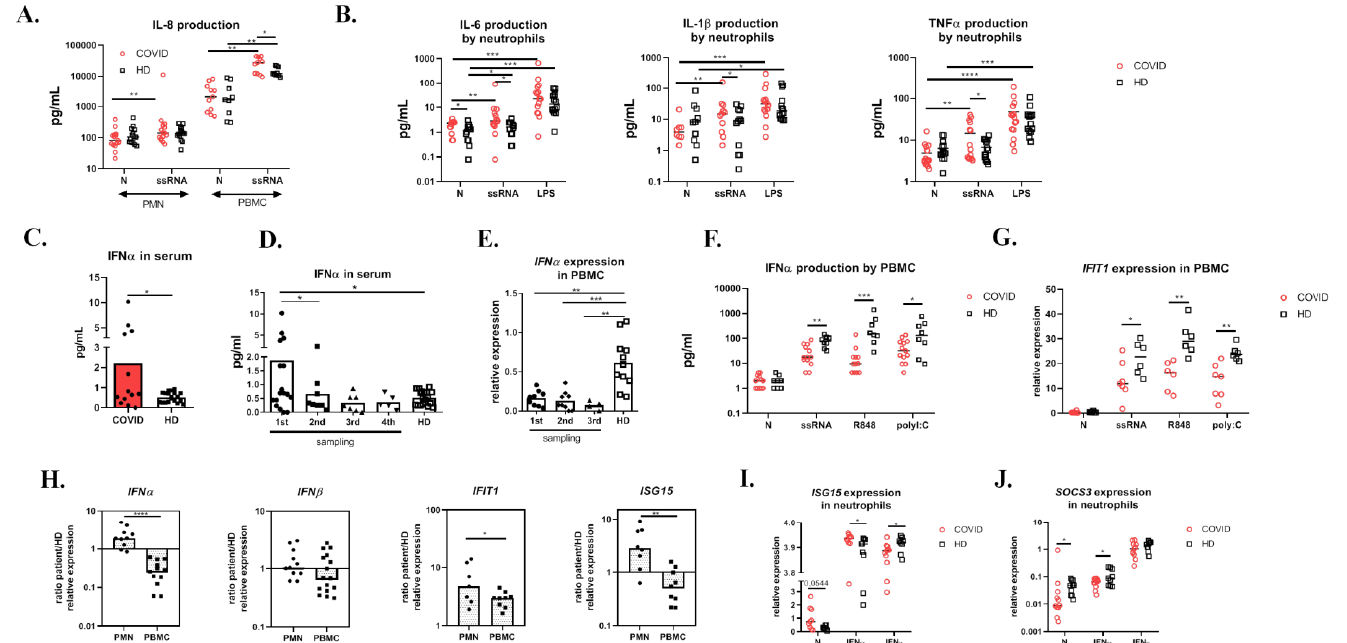
Figure 2. Cytokine production. ( A ) IL-8 concentration in cell-free supernatants of isolated neutrophils and PBMCs from COVID-19 ( n = 15) and HD ( n = 15) upon 10 µ g / mL ssRNA stimulation overnight detected by Luminex. ( B ) Isolated neutrophils from 14 COVID-19 patients and 14 HD were stimulated overnight with 10 µ g / mL ssRNA or left untreated and the production of IL-6, IL-1 β , and TNF α was analyzed with Luminex. ( C ) Serum level of IFN α in 13 COVID-19 and 19 HD analyzed by ELISA. ( D ) Dynamics of serum levels of IFN α during the course of the disease (four di ff erent time points in 1–4 weeks). ( E ) Dynamics of IFN α expression by COVID-19 ( n = 9) and HD ( n = 11) PBMCs during the course of the disease (four di ff erent time points in 1–4 weeks) detected by RT-PCR. ( F ) IFN α production by COVID-19 ( n = 13) and HD ( n = 8) PBMCs upon 10 µ g / mL ssRNA, 1 µ g / mL R848, and 50 µ g / mL polyI:C overnight stimulation detected in cell-free supernatants by Luminex. ( G ) IFIT expression by COVID-19 ( n = 6) and HD ( n = 6) PBMCs upon 10 µ g / mL ssRNA, 1 µ g / mL R848, and 50 µ g / mL polyI:C stimulation for 4 h. Expression was normalized to GAPDH. ( H ) IFN α , IFN β , IFIT , and ISG15 expressions by COVID-19 PBMCs ( n = 9–16) and neutrophils ( n = 7–10). The relative expression was calculated using the following formula (expressed gene / GAPDH of COVID-19 / median of (Expressed gene / GAPDH of all HD samples)). ( I , J ) ISG15 and SOCS3 expression by COVID-19 ( n = 11) and HD ( n = 8) neutrophils stimulated with IFN α (1 µ g / mL), IFN γ (1 µ g / mL) for 4 h, or left untreated. The expression was normalized to GADPH. Statistical analysis was performed using the Wilcoxon paired or Mann–Whitney unpaired t -test. Values of p < 0.05 (*), p < 0.01 (**), p < 0.001 (***), and p < 0.0001 (****) were considered statistically